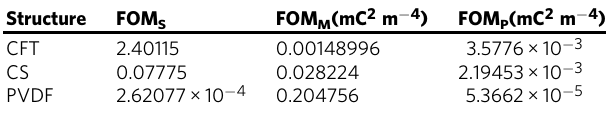
Table 5 Revised fi gures of merit of different nanogenerators